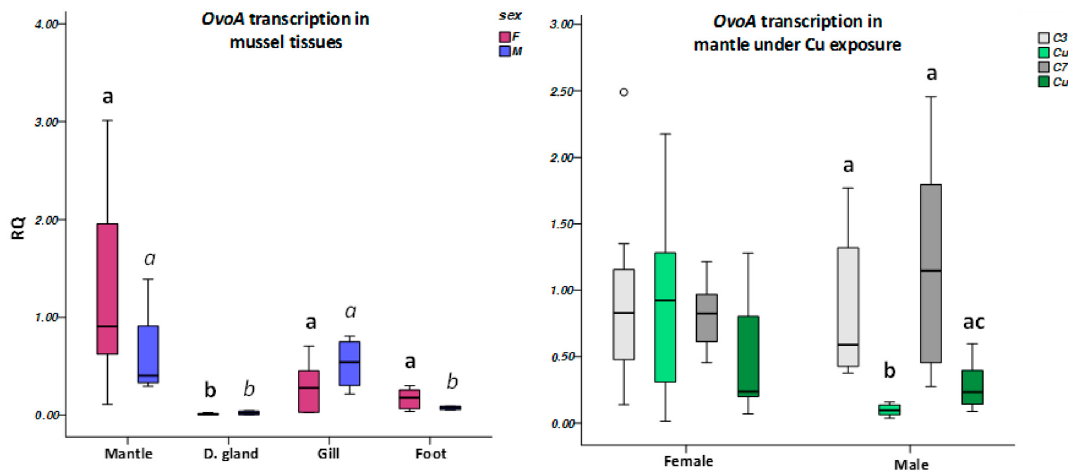
Figure 3. Relative transcription levels of ovo-A in the mantle of mussels exposed to copper and in di ff erent mussel tissues. Box plots represent the data within the 25th and 75th percentiles, with the median indicated by a line, and top and bottom whiskers indicating the minimum and maximum values ( n = 6 individuals per experimental group). The first graph shows transcription levels in male and female mantel after 3 and 7 days of exposure to copper respect to controls. The second graph represents the transcription levels in four di ff erent tissues of male and female mussels collected in Plentzia in May. Where significant di ff erences were detected, they are indicated by di ff erent letters on top of the Box plots ( p < 0.05). In the tissue comparison, bold letters are used to indicate di ff erences between female tissues and letters in italics to indicate di ff erences in males. No significant di ff erences were observed in female